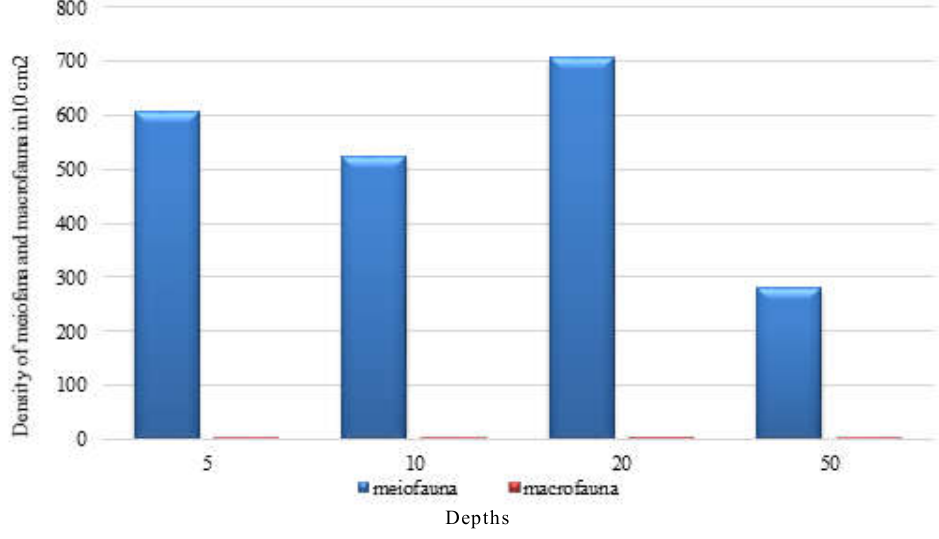
Depths Fig. 5: Density of living meiobenthos in different depths (m) (in Mazandaran province) Fig. 6: Density of living meiobenthos in different stations (in Mazandaran province)